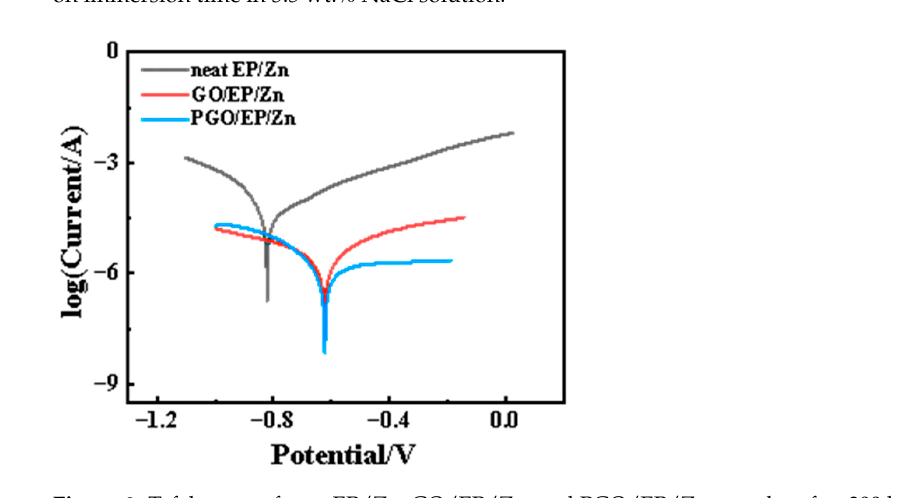
Figure 9. Tafel curve of neat EP/Zn, GO/EP/Zn, and PGO/EP/Zn samples after 300 h of immersion in 3.5 wt.% NaCl solution. Table 3. Icorr and Ecorr of neat EP/Zn, GO/EP/Zn and PGO/EP/Zn coatings after 300 h of immersion in 3.5 wt.% NaCl solution.